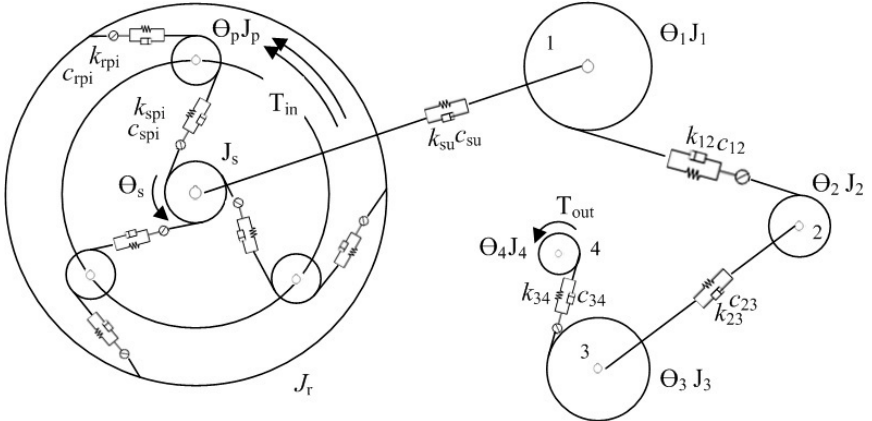
Figure 3. Dynamic model of the three-stage gearbox.